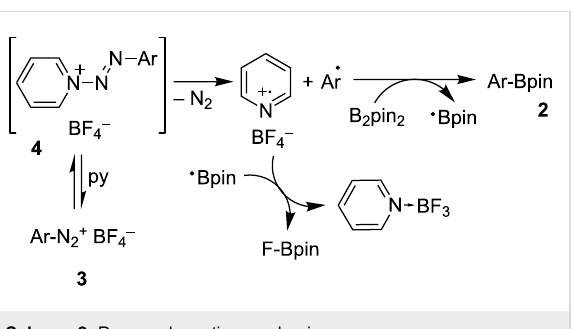
Scheme 2: Proposed reaction mechanism.